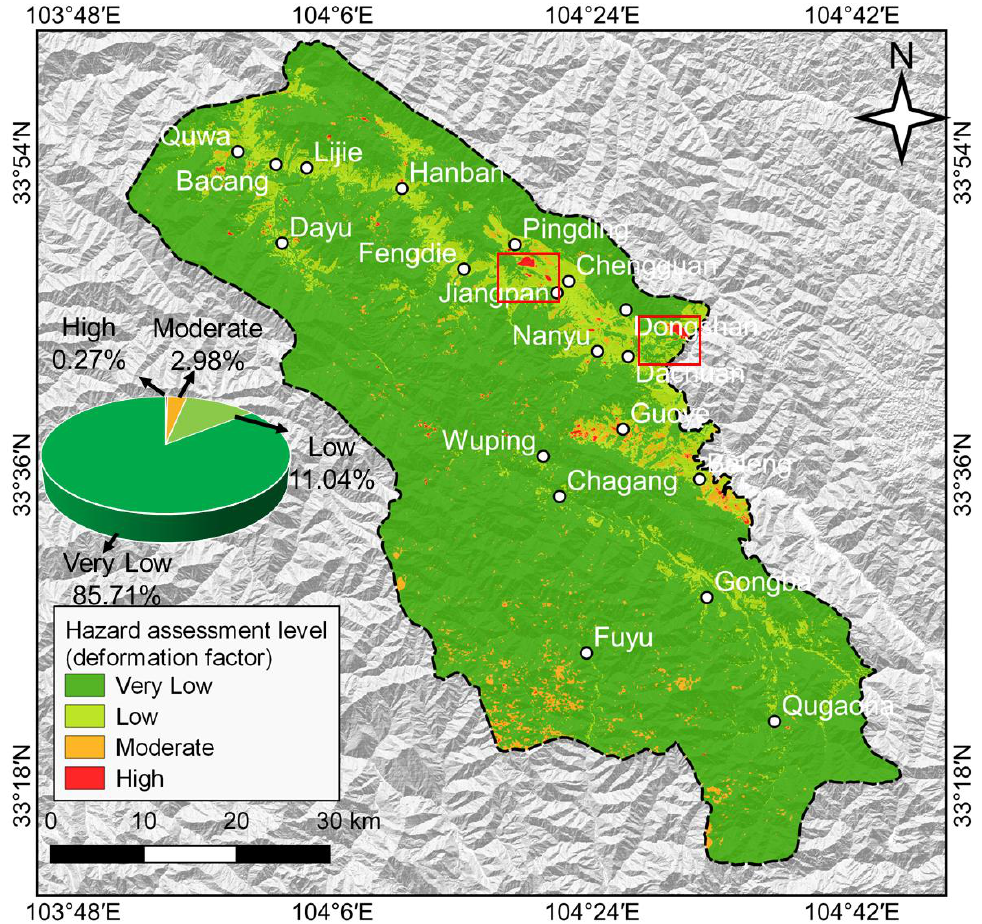
Figure 15. Hazard assessment levels obtained while considering the deformation factor in Zhouqu (The red border is a high-hazard area identified through the hazard assessment method considering the deformation factor).